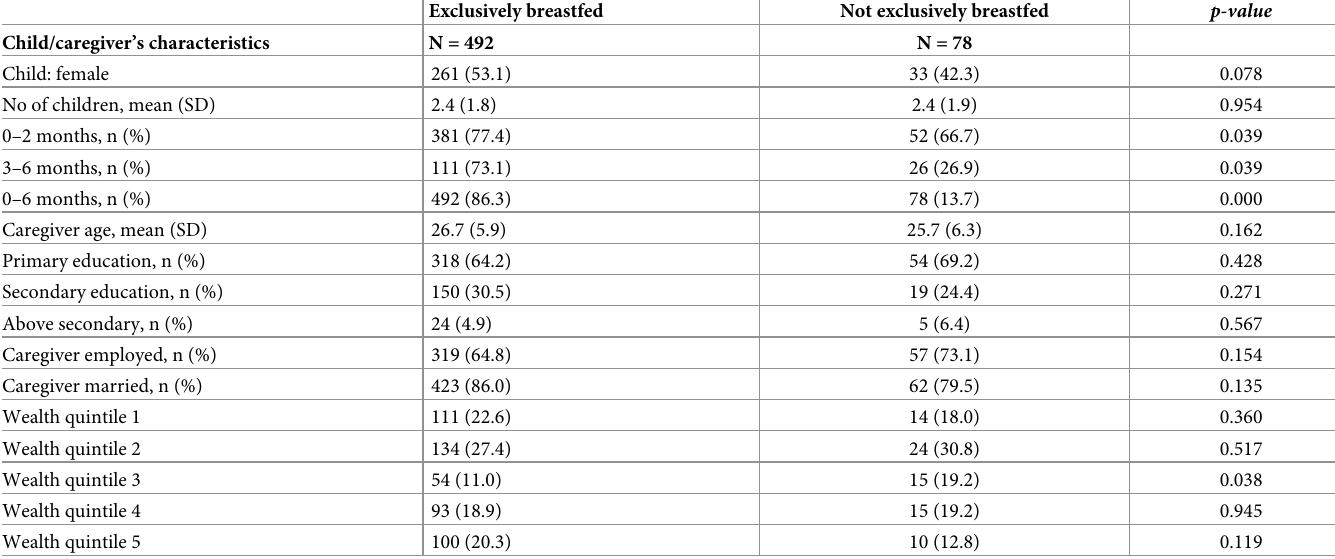
Table 1. Descriptive statistics (caregivers’ baseline